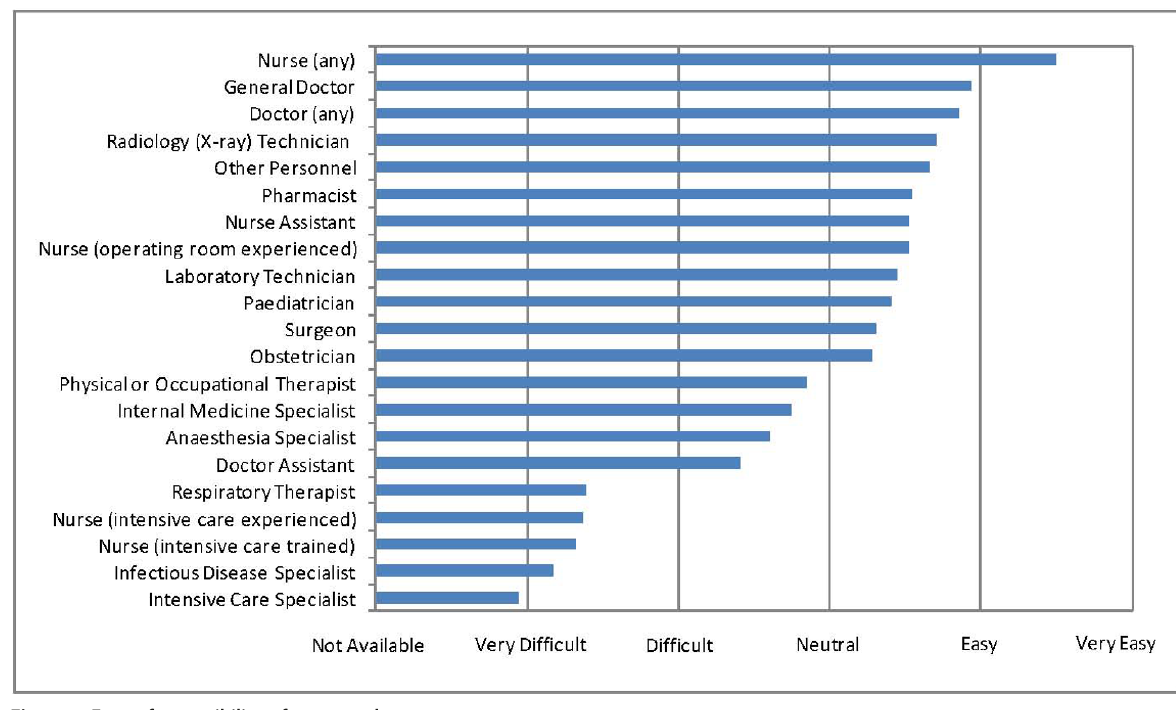
Figure 4 Ease of accessibility of personnel